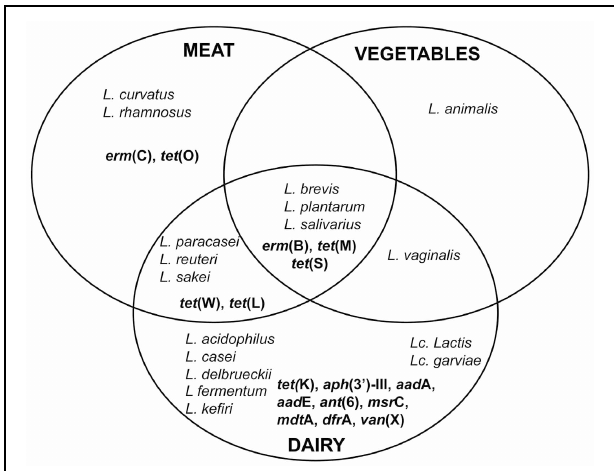
FIGURE 1 | Eulero-Venn diagram representing the distribution of ARLb and ARLc, as well as of the AR genes, in the different food sources (dairy, meat, vegetable). AR genes are indicated in